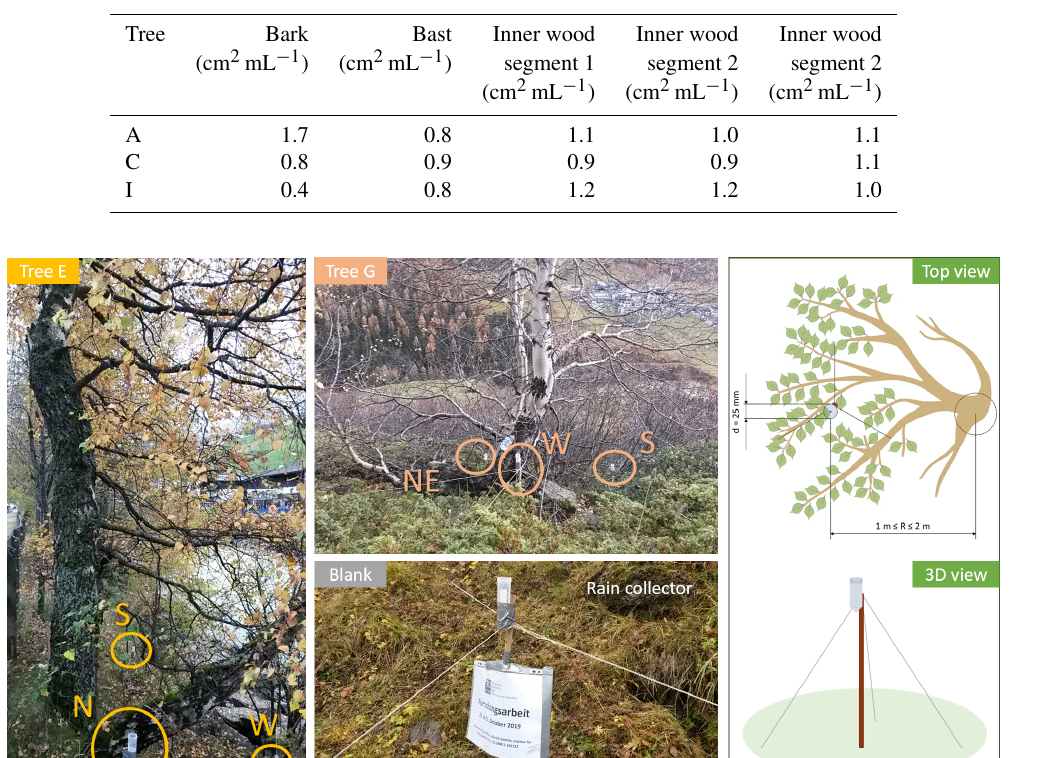
Table 2. Surface area per millilitre of extracted water (ultra-pure) for drill core samples from Tree A, C and I. Bark and bast segments are the outermost layers, followed by three layers of the inner wood (1–3).